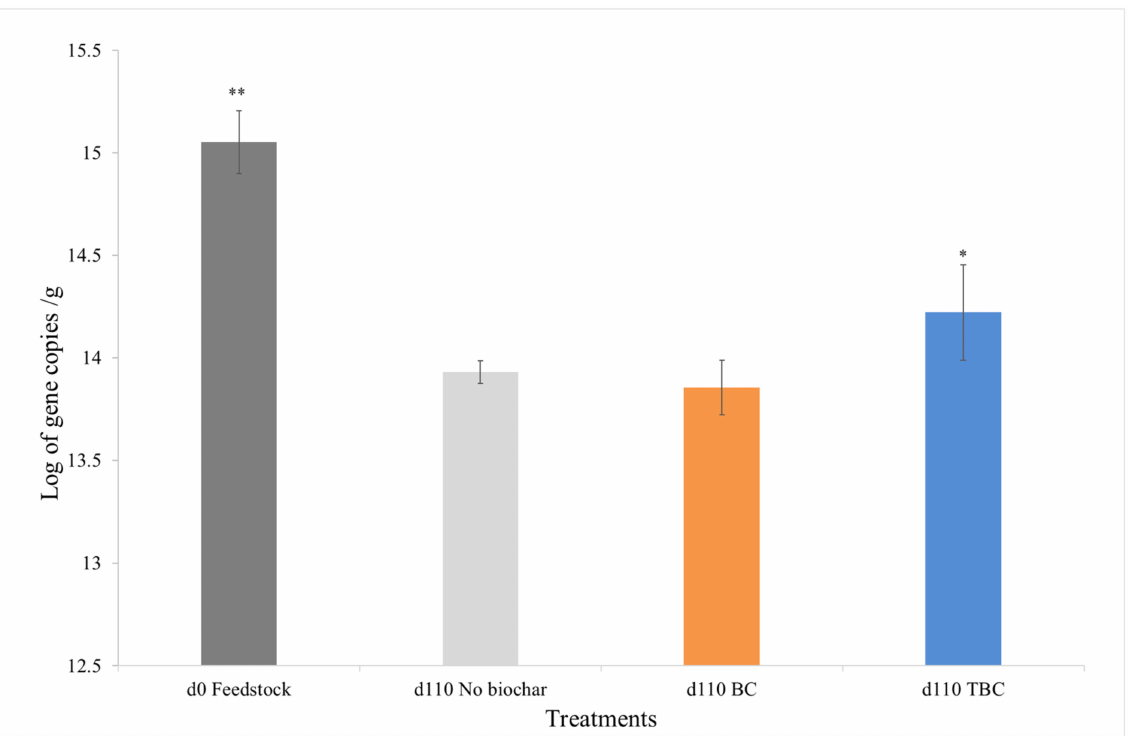
Figure 2. Changes in microbial biomass (assessed as log 10 16SrRNA gene copies) per gram of day 0 feedstock and 3, day 110 digestates: control (No biochar), wood biochar treatments (BC) and treated biochar treatments (TBC), with error bars. The results shown are the means of three replicates, ** represents significant differences between d0 and d110 samples, * represents significant differences between all d110 samples for the three